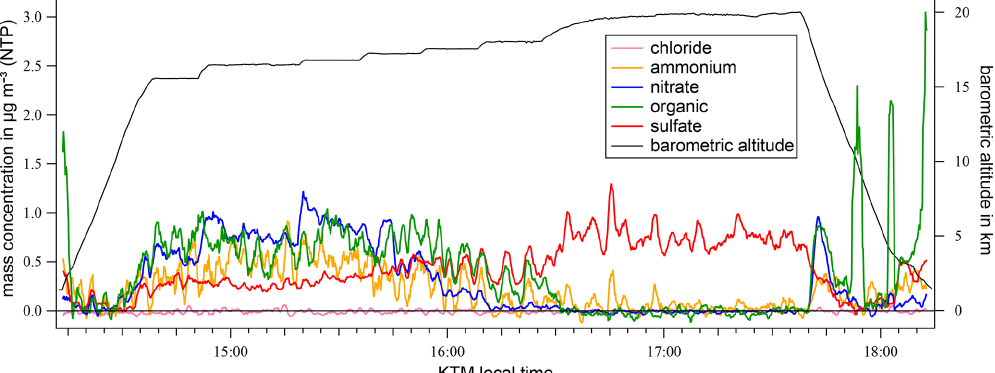
Figure 11. Time series of the mass concentrations of different aerosol species recorded and identified by the ERICA-AMS during flight KTM 4 from Kathmandu on 2 August 2017. Data were smoothed with a running mean over